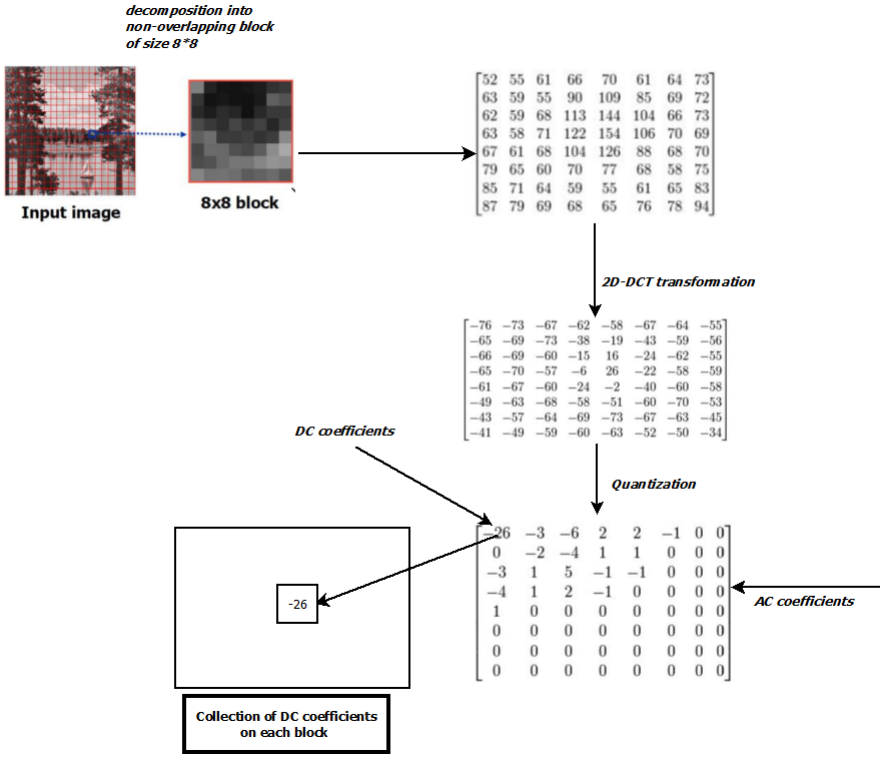
Figure 6: Principle of insertion